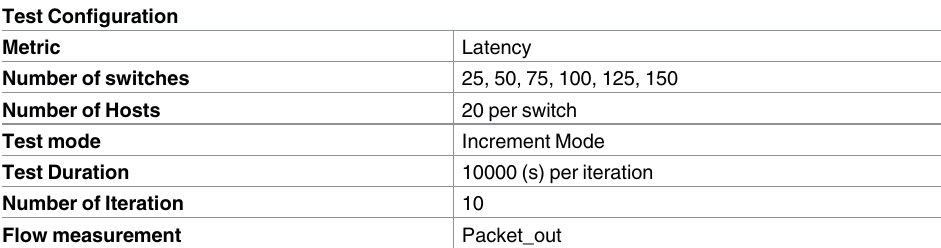
Table 3. Test configuration metricsfor both controllers.